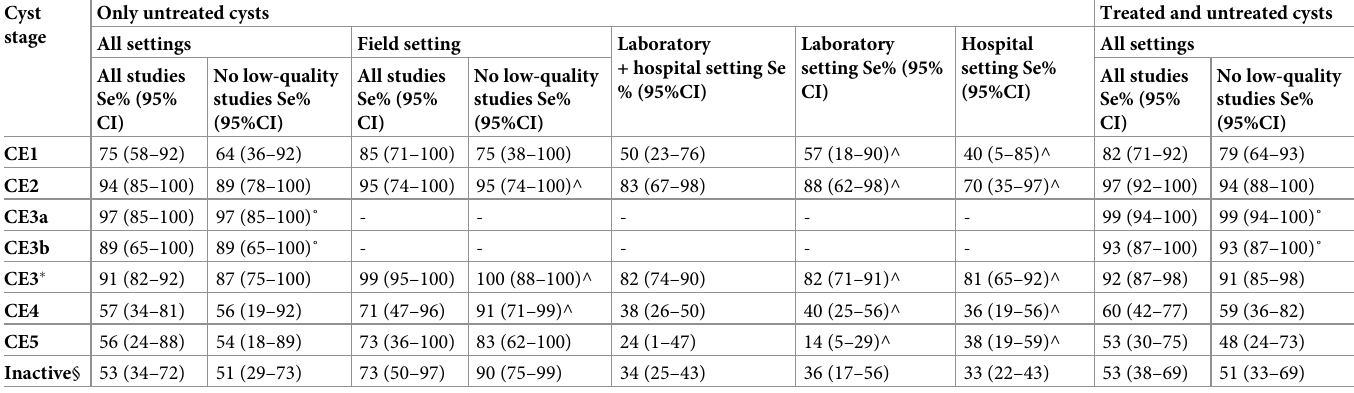
Table 2. Estimated sensitivity (Se %) with 95%CI of ELISA test with best